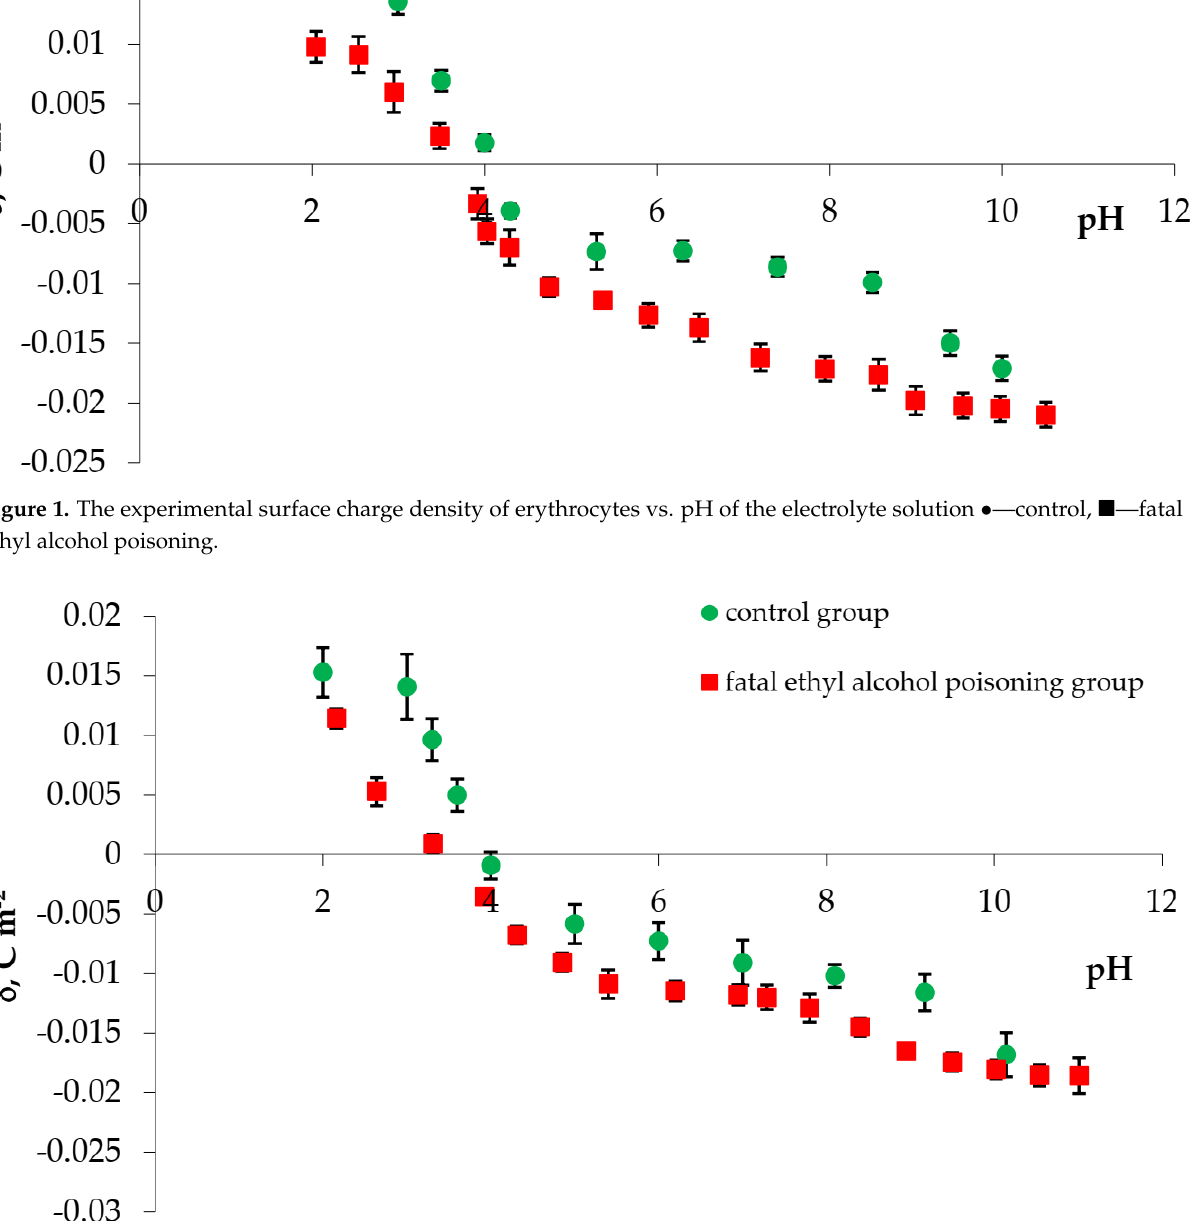
Figure 2. The experimental surface charge density of thrombocytes vs. pH of the electrolyte solution: • —control, (cid:4) —fatal ethyl alcohol